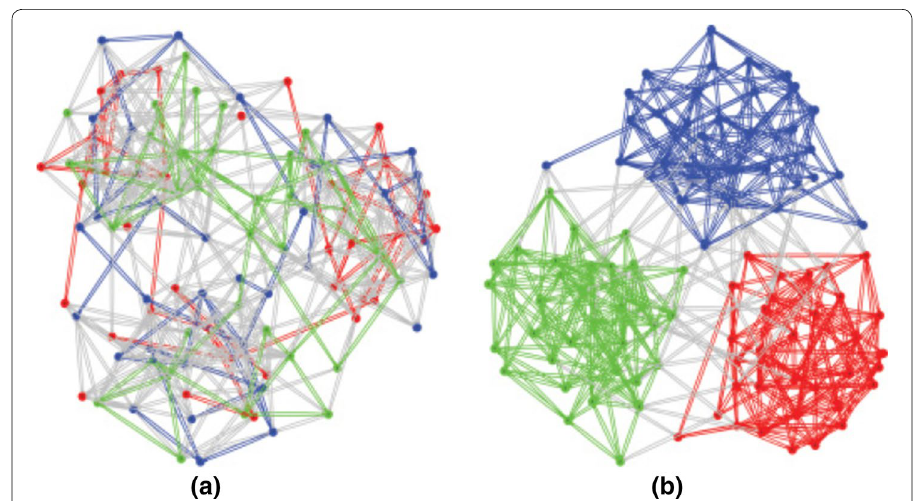
Fig. 2 Illustration of an example of partitioning : a the partitioning is shoddy, the vertices are assigned randomly, there are more cut-edges between partitions; b the partitioning is almost optimal, the highly connected vertices reside in the same partition, there is less cut-edges